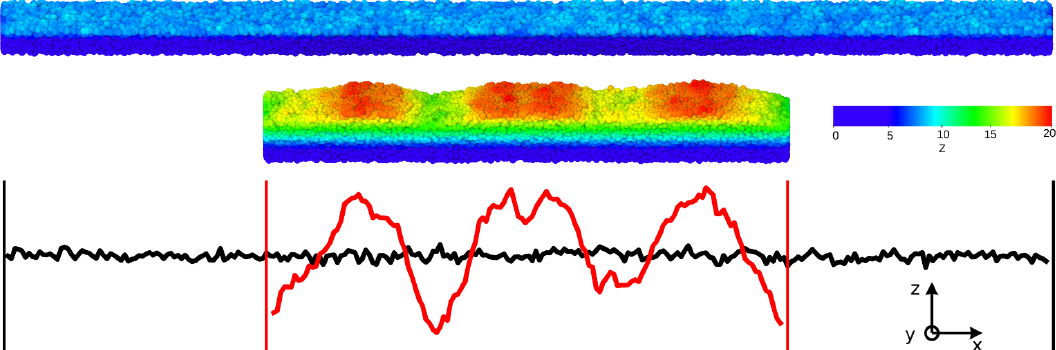
Figure 2. Slices with depth 13 σ of a glassy film of pristine height h 0 = 9 σ and length L 0 ( L 0 = 300 σ ) compressed to length L = L 0 /2. Hotter colors indicate particles with higher elevations z . The black and red curves represent the surface topography of the uncompressed and compressed systems, respectively. Both the elevation and the film lengths are in units of the reference length σ , the approximate monomer diameter. In the case of polyethylene (polystyrene), one deduces a reference length σ = 5.3 ( 9.7 ) Å; see Section 3.